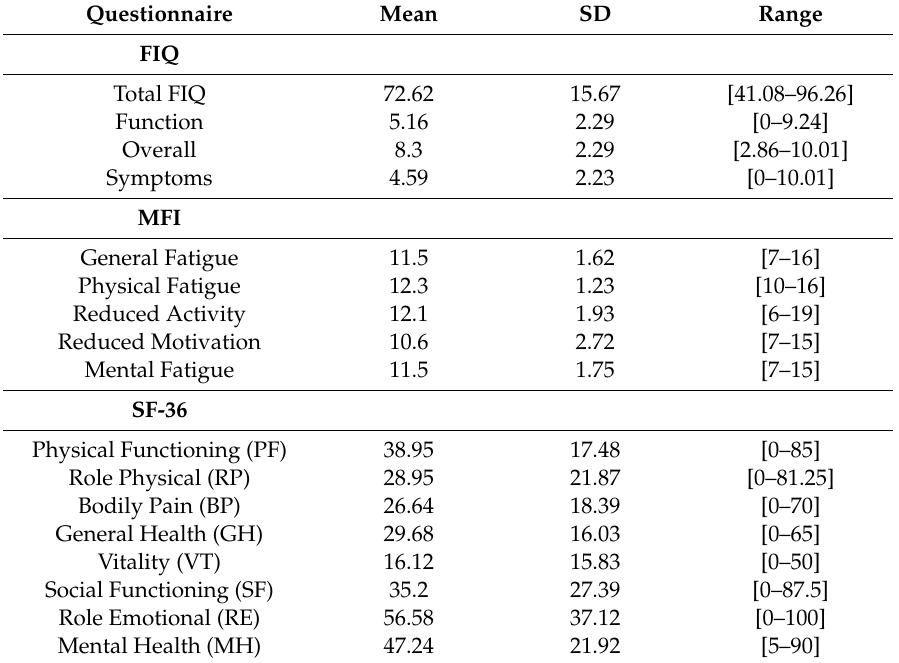
Table 1. Patient health status assessment with the FIQ, MFI and SF-36 instruments [36–39] at baseline ( n =